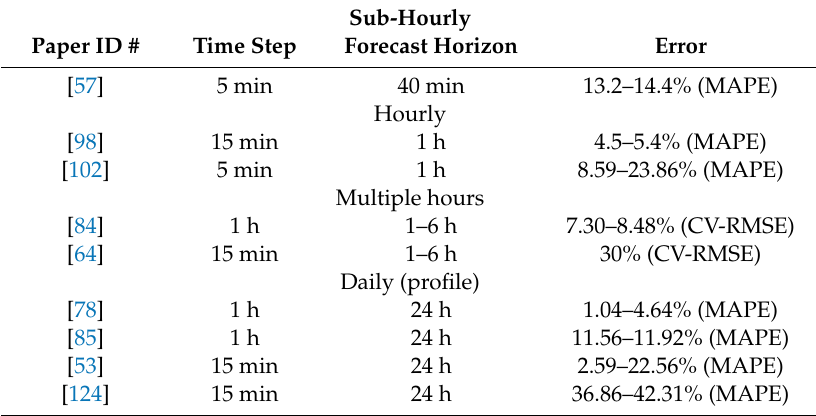
Table 3. Performance range of multi-step ahead forecasting